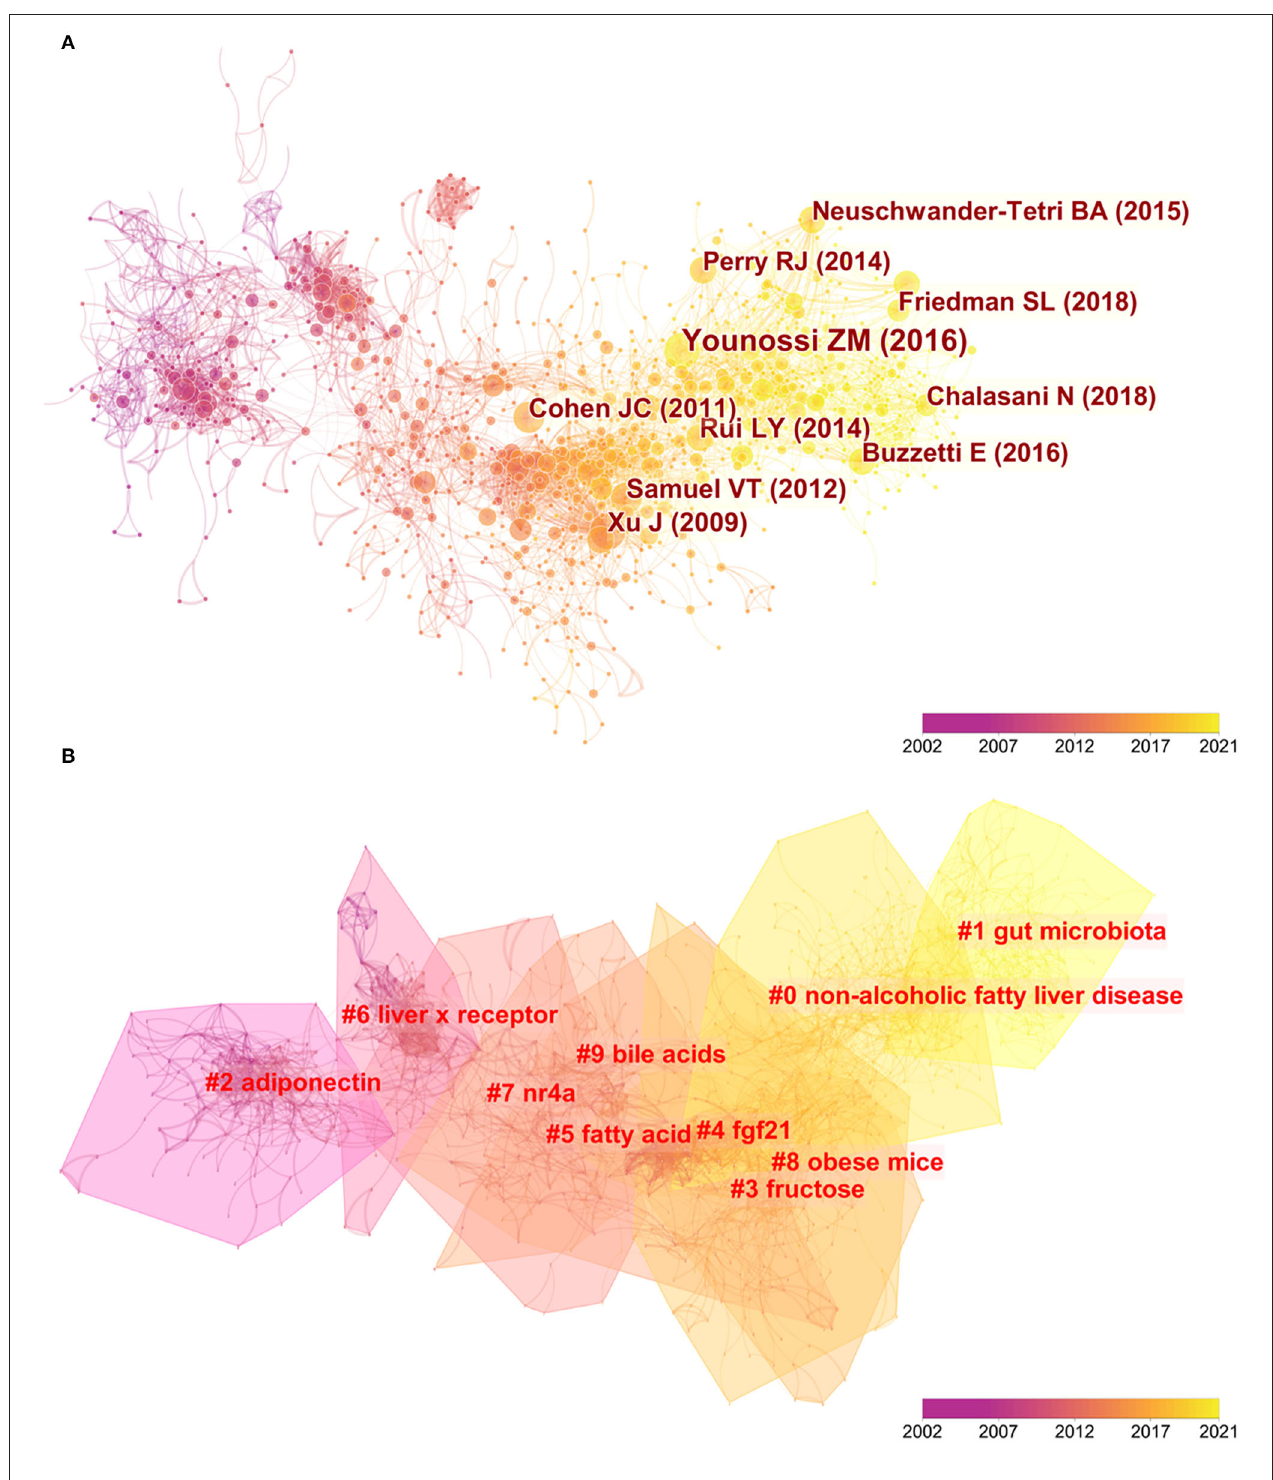
FIGURE 5 | (A) A CiteSpace co-citation map of 157,691 references on hepatic glycolipid metabolism, a filter option showing the largest connected component only. Each node represents a reference, and the link between nodes means these articles were cited as references in the same article within the retrieved 4,856 articles. The size of node is positively related with the frequency of citation, and line thickness means the correlation with the co-cited papers. The yellower nodes represent that these papers have been frequently cited in recent years, while the redder ones represent those references cited in earlier years. (B) Clustered networks of co-citation status of the investigated reference and the 4,856 citing articles via CiteSpace. The top 10 largest clusters of citing articles are shown.